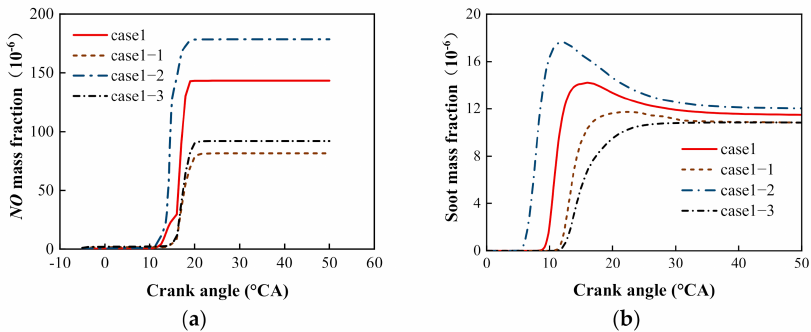
Figure 11. Emission characteristics for diverse pilot injection ratio schemes: ( a ) NO ; ( b )